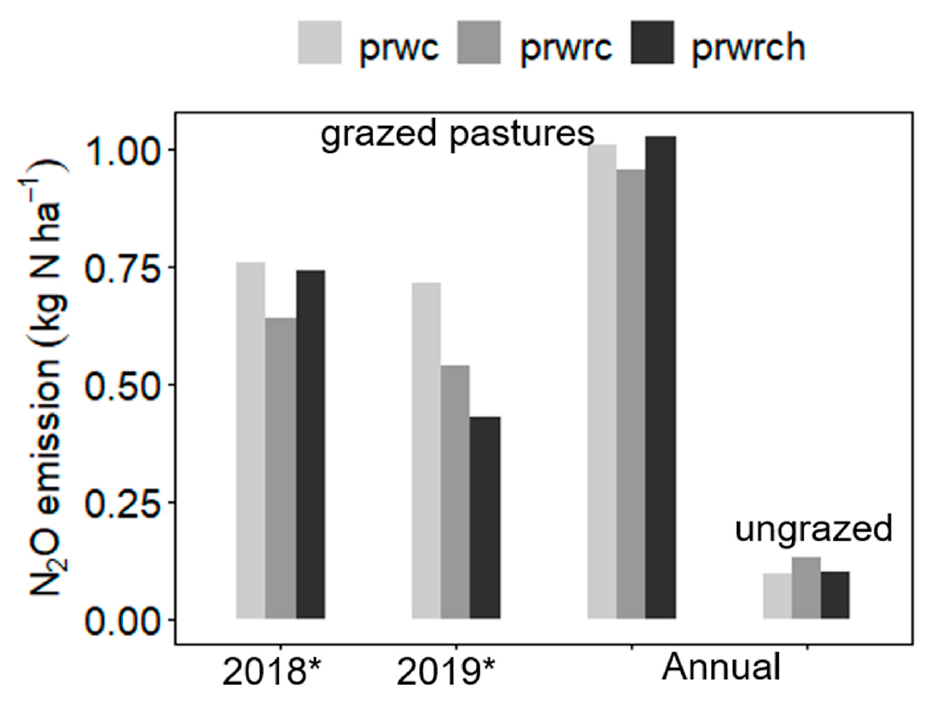
Figure 3. Mean values of the N 2 O-N emission from diverse pastures grazed by dairy cows in a 3–5 week rotational cycle. Error bars are the standard error of the mean; * accumulated for eight months (May–December); the annual mean was accumulated from May 2018 to April 2019. prwc : Perennial ryegrass and white clover swards; prwrc : Perennial ryegrass, white- and red clover swards; prwrch : Perennial ryegrass, white- and red clover +